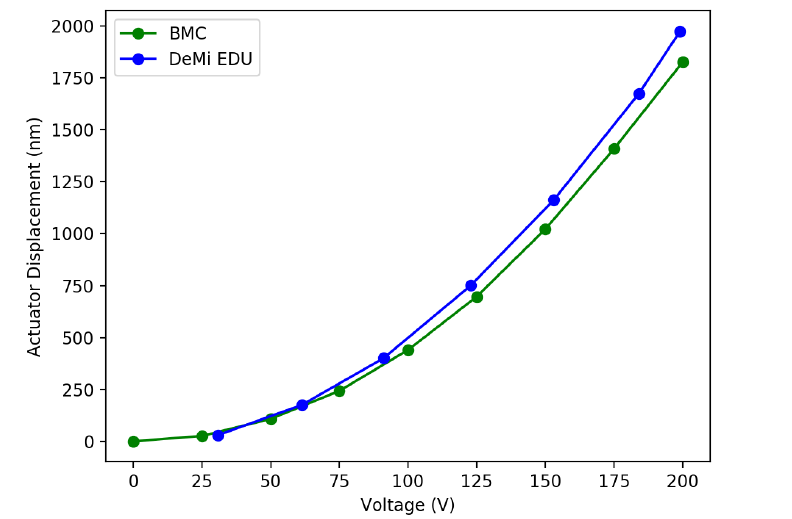
Figure 8. Results from miniaturized DM driver tests. Plot shows single actuator displacements measured from spot displacements on the Shack Hartmann WFS vs. the input voltage. Blue line is DeMi COTS-based miniaturized driver performance and green line is reported values from BMC. The mean difference between the DeMi driver and BMC measurements was